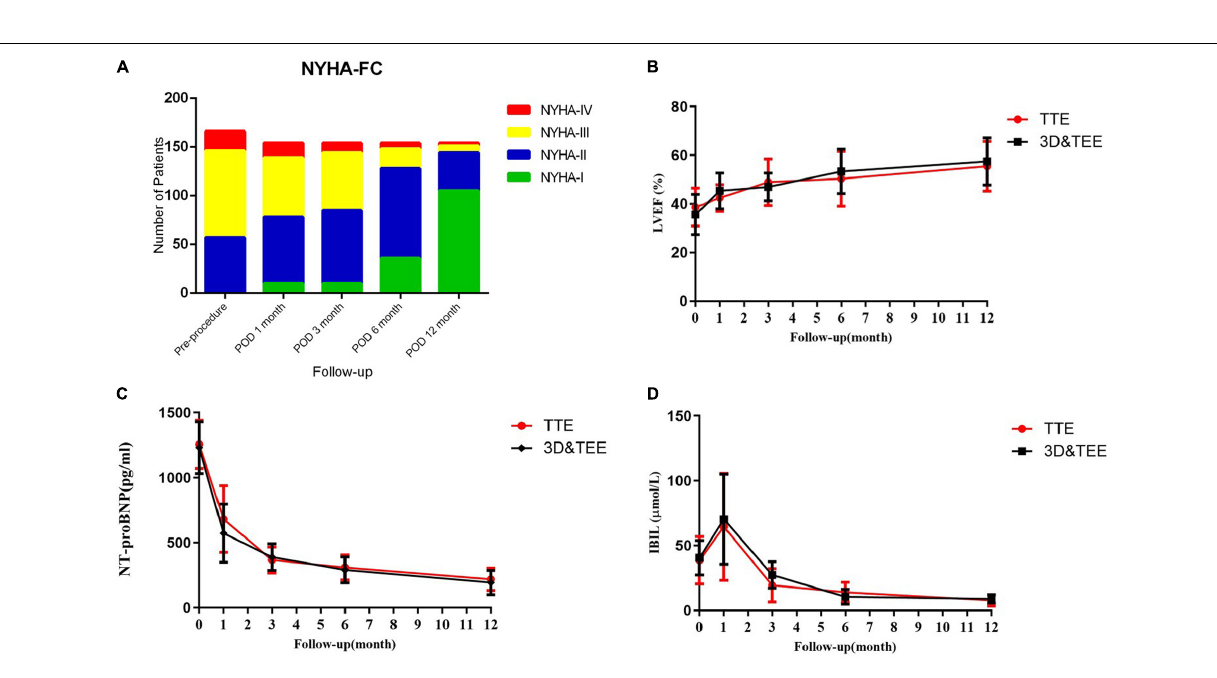
FIGURE 7 | The 1-year follow-up of TTE and transesophaeal echocardiography and the 3-dimensional (TEE&3D) groups. (A) Improvement of the New York Heart Association functional class during the 1-year follow-up period. (B) The left ventricular ejection fraction during the 1-year follow-up period (TEE&3D vs. TTE, p > 0.05). (C) NT-proBNP levels during the 1-year follow-up period (TEE&3D vs. TTE, p > 0.05). (D) Indirect bilirubin levels during the 1-year follow-up period (TEE&3D vs. TTE, p >